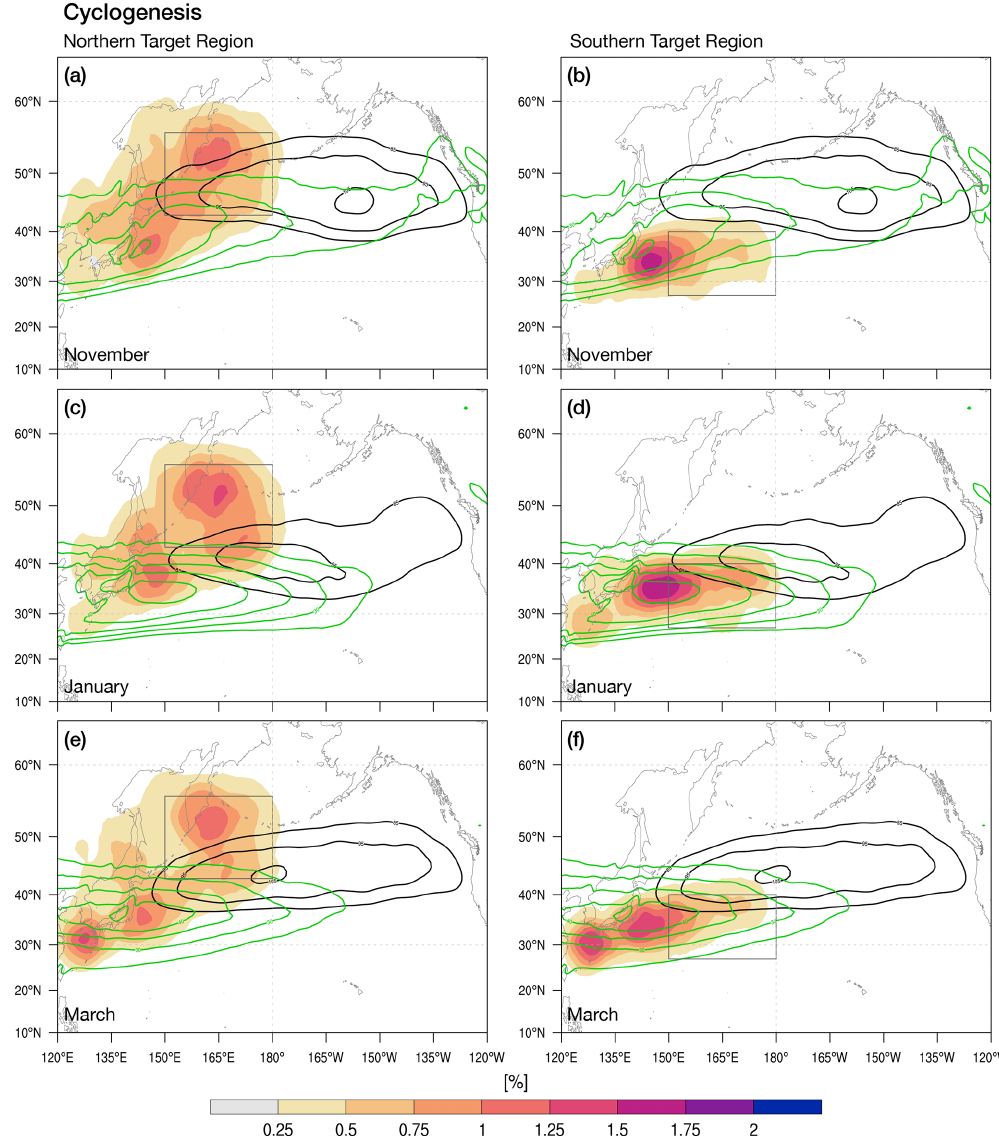
Figure 2. Cyclogenesis frequency (color shading; %) for surface-cyclone tracks that propagate through the northern (a, c, e) and south- ern (b, d, f) target regions (shown as a gray box) for (a, b) November, (c, d) January, and (e, f) March. Additionally shown are EKE (black contours; 85, 95, and 105Jkg − 1 ) and baroclinicity (green contours; 25 to 45 × 10 − 6 s − 1 by steps of 5 × 10 − 6 s − 1 ) at the 500hPa level.